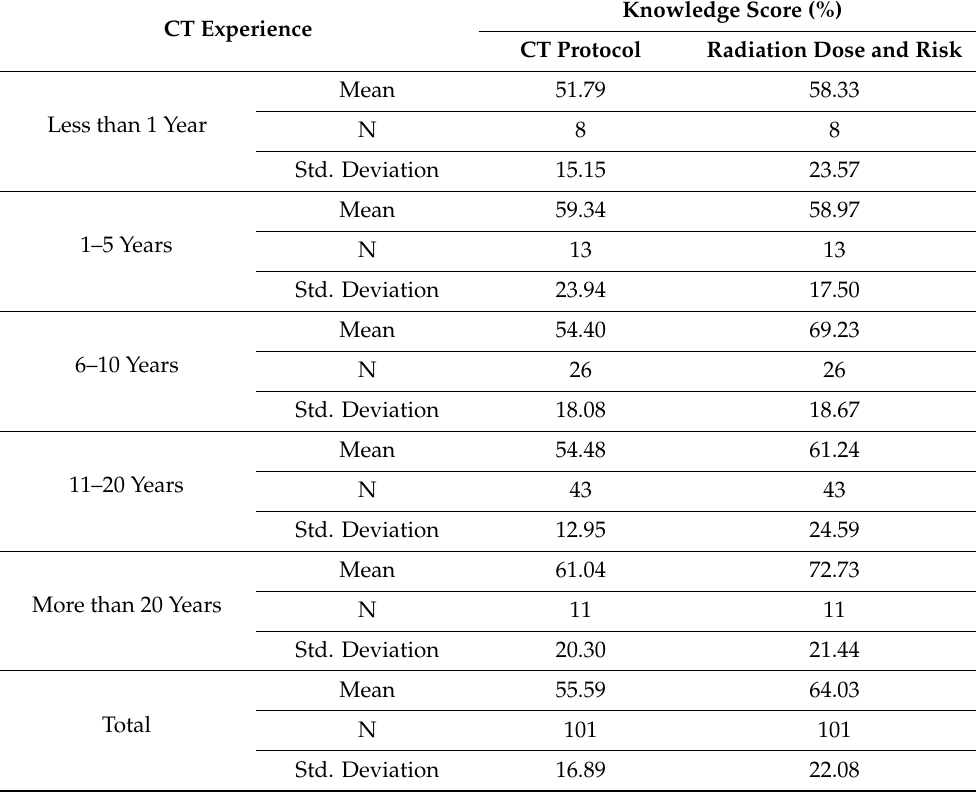
Table 4. Comparison of participants (cid:48) knowledge of CT protocol and radiation dose based on